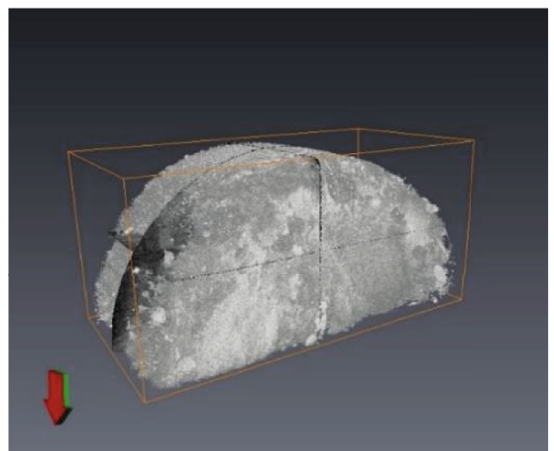
Figure 3: Three-dimensional volume of CT image. The size of the core sample and pixels in the fi gure are the same as those in Figure 2.